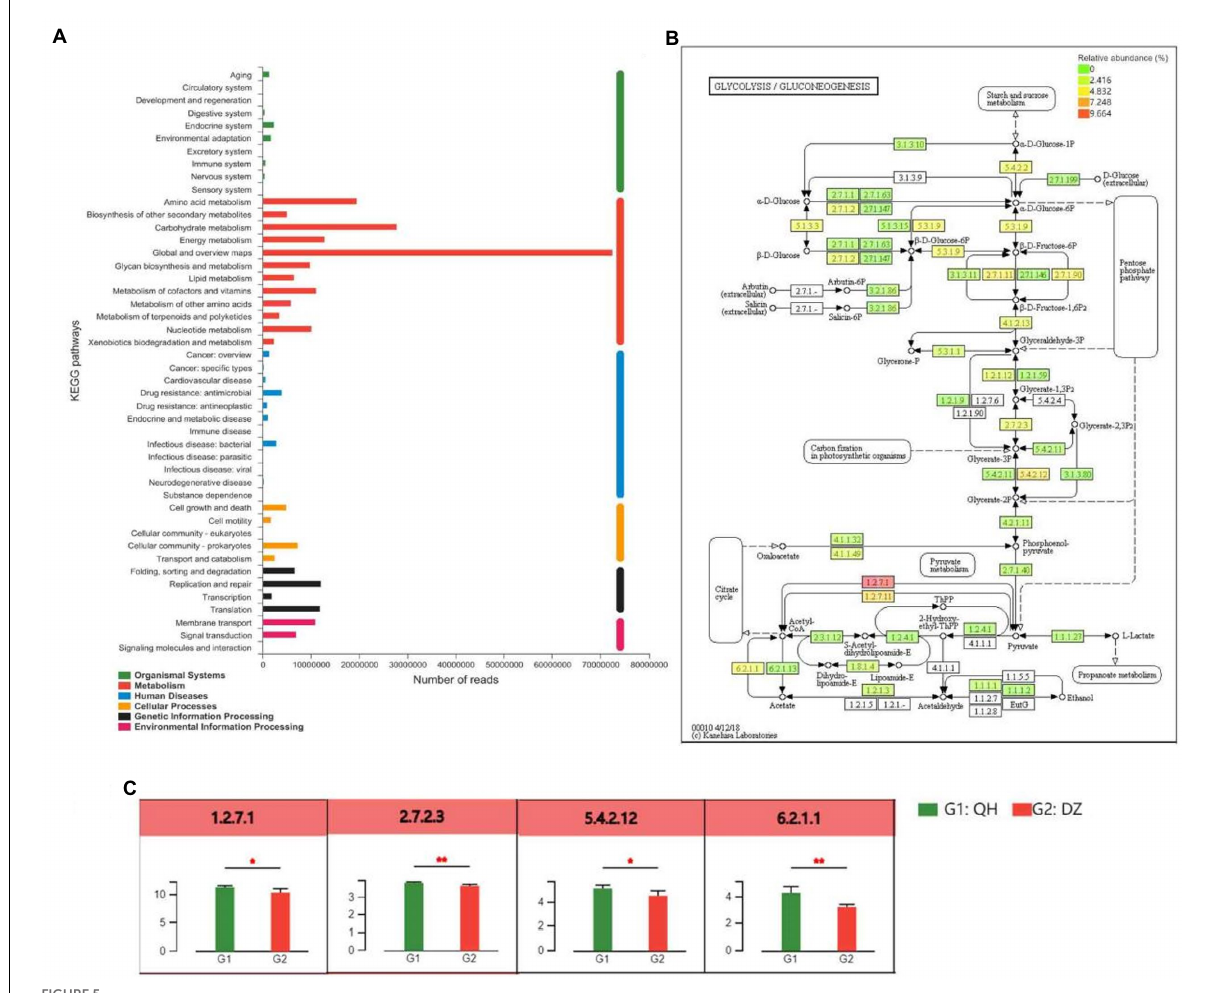
FIGURE 5 Differences between metabolite groups. (A) Pathway classification statistics histogram. The ordinate was the function name of KEGG Pathway Level 2, and the abscissa was its corresponding abundance value. The histogram was colored according to the KEGG Pathway Level 1 to which KEGG Pathway Level 2 belongs. (B) Metabolic pathway difference test chart between groups. Each square in the box with a fill color represents one or a group of samples. The intensity of the color represents the abundance change in the enzyme in different samples or groups. (C) Histogram of differences in metabolic pathways between groups. In the legend, G1 and G2 correspond to different